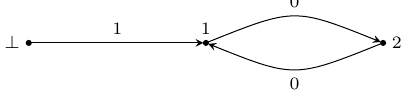
Figure 2: Let M 1 = (1 , 0 , 0 , 0 , 0) and f (1) = 2, f (2) = 1. For any such f , we have out f = (0 , 2 , 1 , 2 , 1 , 2) and in f = ( ⊥ , 1 , 2 , 1 , 2 , 1). However, the graph consists of three vertices {⊥ , 1 , 2 } and edge set E = { ( ⊥ , 1 , 1) , (1 , 2 , 0) , (2 , 1 , 0) }